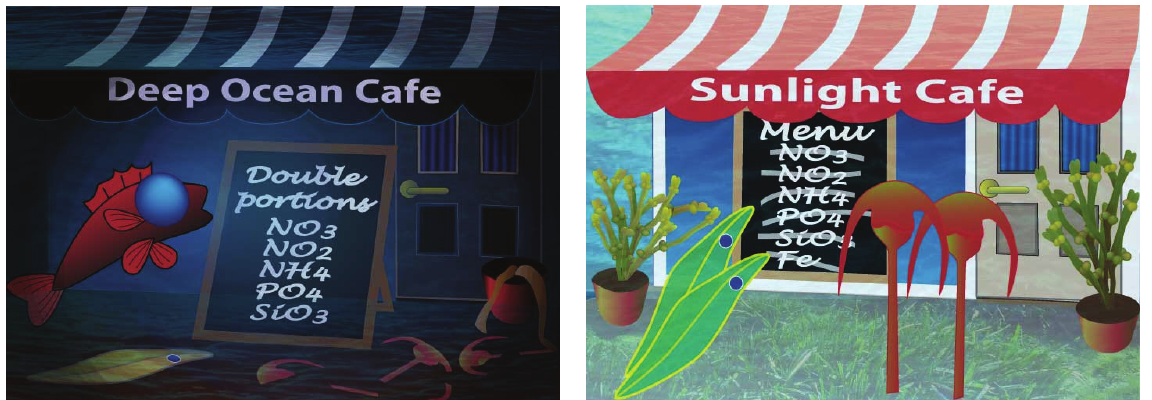
Figure 3: Illustrations from the tutorial Marine Currents , depicting the distribution of nutrients in seawater which is a limiting factor of phytoplankton growth. Nutrients are abundant in the deep oceans where sunlight is scarce (left). In the near-surface layers this is the other way around (right). The role of wind and ocean currents and physics as a driving factor of biological processes is explained in the tutorial. Courtesy: National Oceanographic Laboratory, Southampton,